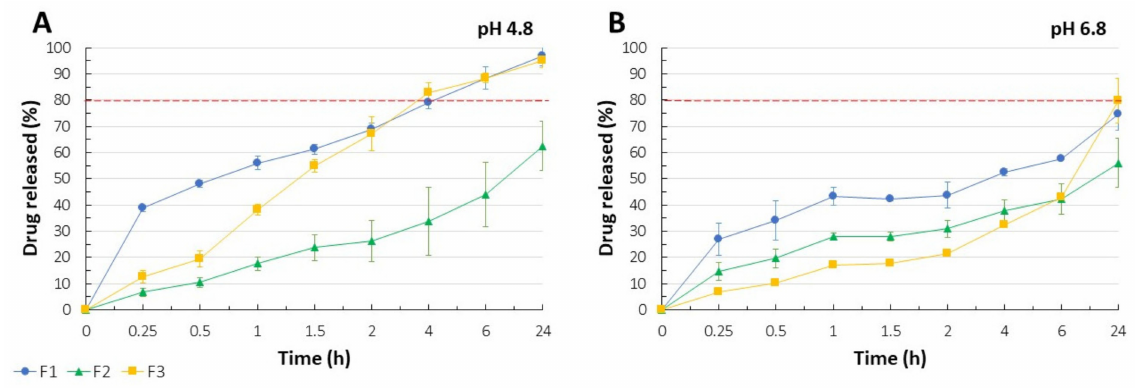
Figure 3. CLO release profiles noted for F1–F3 films in the SS at pH 4.8 ( A ) and pH 6.8 ( B ) at 37.0 ± 0.5 ◦ C (mean ± SD, n =